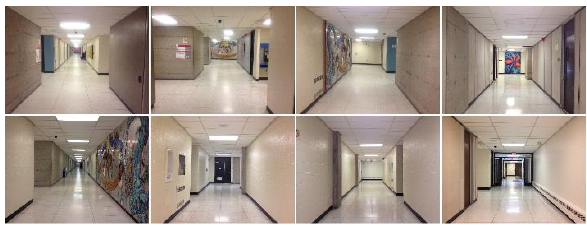
Figure 1. Sample images acquired at Ross building first